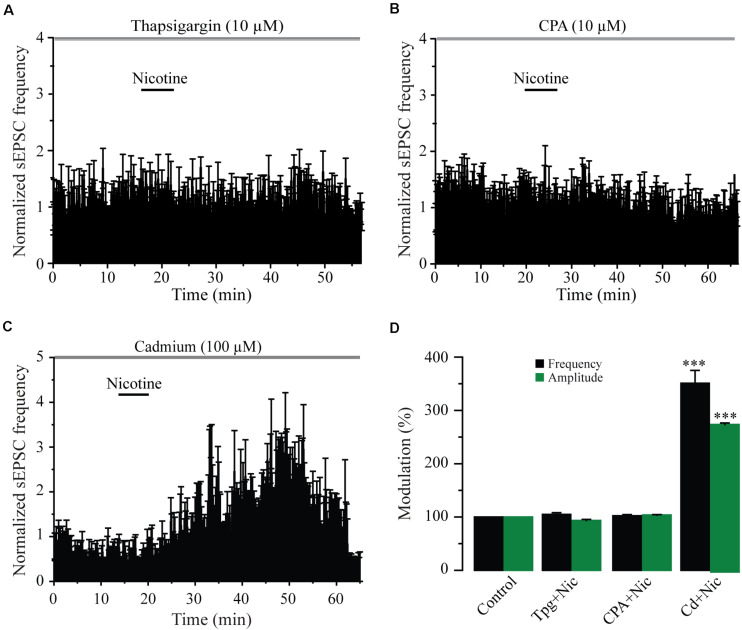
Blockage of intracellular calcium stores abolishes the effects of nicotine. (A) Time-frequency histogram showing the lack of effect of nicotine on the sEPSC frequency in the presence of the SERCA blocker thapsigargin (10 μM) (n = 6). (B) Time-frequency histogram showing the lack of effect of nicotine on the sEPSC frequency in the presence of cyclopiazonic acid (CPA, 10 μM) (n = 6). (C) Time-frequency histogram showing that nicotine had strong effects on sEPSCs in the presence of cadmium (100 μM), a blocker of the VGCCs (n = 6). (D) Bar graph illustrating a summary of the data (Mann–Whitney U-test). ***p < 0.001.